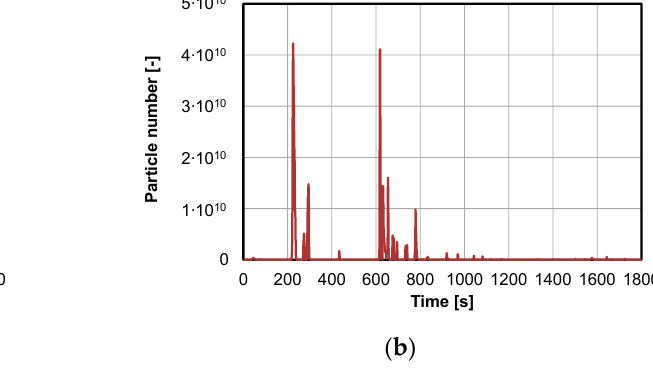
( b ) Figure 21. The fuel consumption (FC) versus time for: ( a ) plug-in; ( b ) HEV. The particle number (PN) rates during the tests are shown in Figure 22a for the plug- in and in Figure 22b for HEV. In the case of the plug-in in the first half of the test, the PN rate was equal to zero. In the second half of the test, the PN rate varied between the lower and upper limits, due to driving with an electric motor, with relatively close values in- creasing with the increase in actual velocity. For the actual velocity values in the range of 20–60 km/h, the upper PN rate limit reached much higher values and varied in a complex manner with an increase in the actual velocity. In the case of HEV, the variations of PN rate were similar to those of the plug-in case in the second half of the test. The lower PN rate limit increased almost twice as quick with the increase in actual velocity compared to the plug-in case in the second half of the test. In both cases, the PN rate variations were due to driving with a competitive choice between a combustion engine and electric motor,